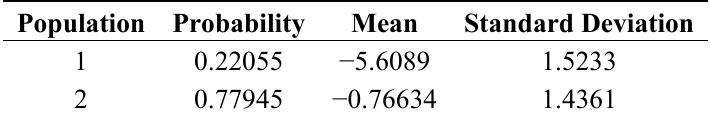
Table 1. Data of the mixture populations (transformed variable).